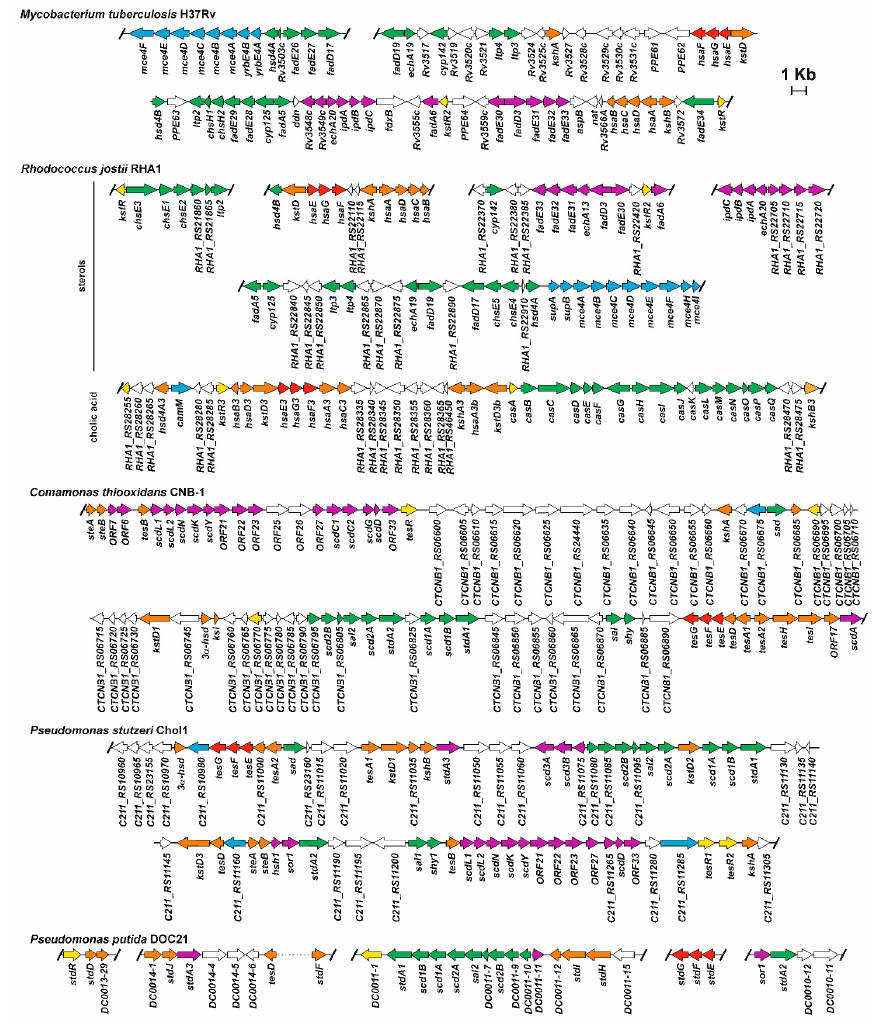
Figure 4. Genetic organisation of the genes encoding the 9,10- seco pathway involved in cholesterol ( Mycobacterium tuberculosis H37Rv, Rhodococcus jostii RHA1), or in cholic acid and testosterone ( R. jostii RHA1, Comamonas thiooxidans CNB-1 (formerly, Comamonas testosteroni CNB-2), Pseudomonas stutzeri Chol1 (formerly Pseudomonas sp. Chol1), and Pseudomonas putida DOC21 catabolism. Genes coding enzymes involved in cholesterol or bile acids side chain degradation are shown in green; genes participating in ring A / B degradation are in orange; in purple are shown genes coding for ring C / D degradation; blue color indicates genes coding transport